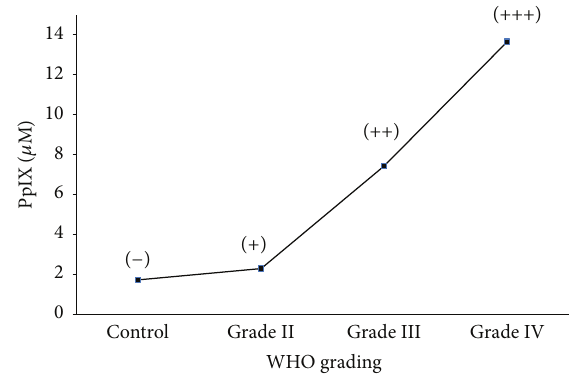
Figure 5: The amount of PpIX accumulation in each grade of glioma. High-grade malignant glioma contains a high concentration of PpIX in the tissue. This sign of ( − ) ∼ (+++) shows the intensity of fluorescence to the naked